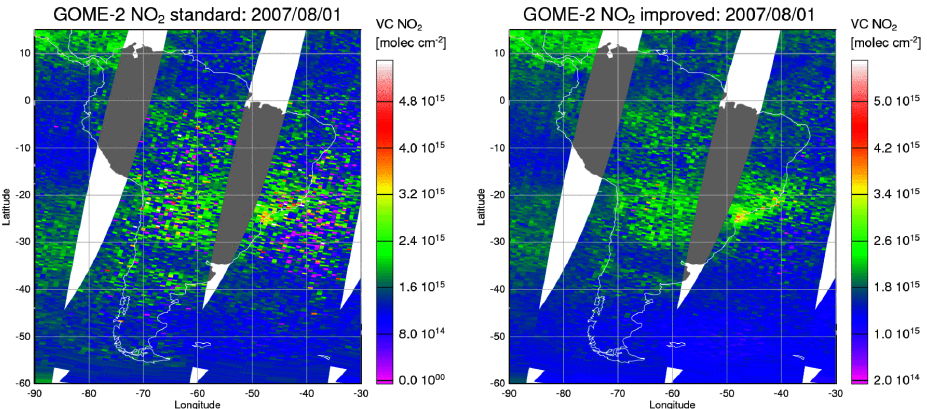
Fig. 3. Individual overpasses of GOME-2 NO 2 data in the region of the Southern Atlantic Anomaly. Left: standard analysis, right: improved data product. Slightly different colour scales have been used to compensate for the small offset between the NO 2 columns from the two retrievals.